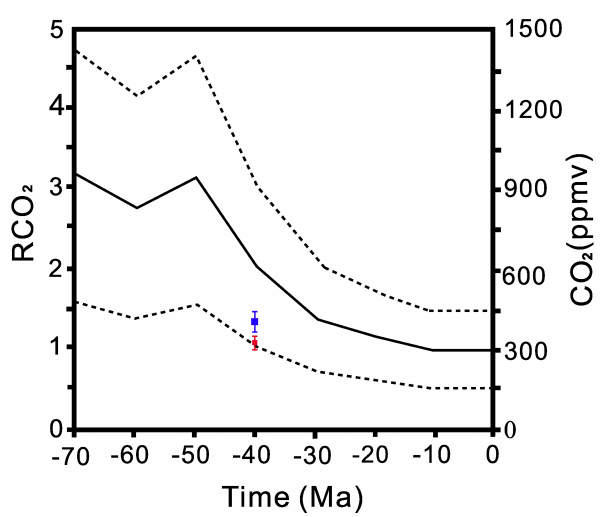
Figure 5. The p CO 2 reconstruction results and extant CO 2 con- centrations are projected onto the long-term carbon cycle model (GEOCARB III; Berner and Kothavalá, 2001). The p CO 2 results based on the regression approach and stomatal ratio method are rep- resented by red and blue squares, respectively.